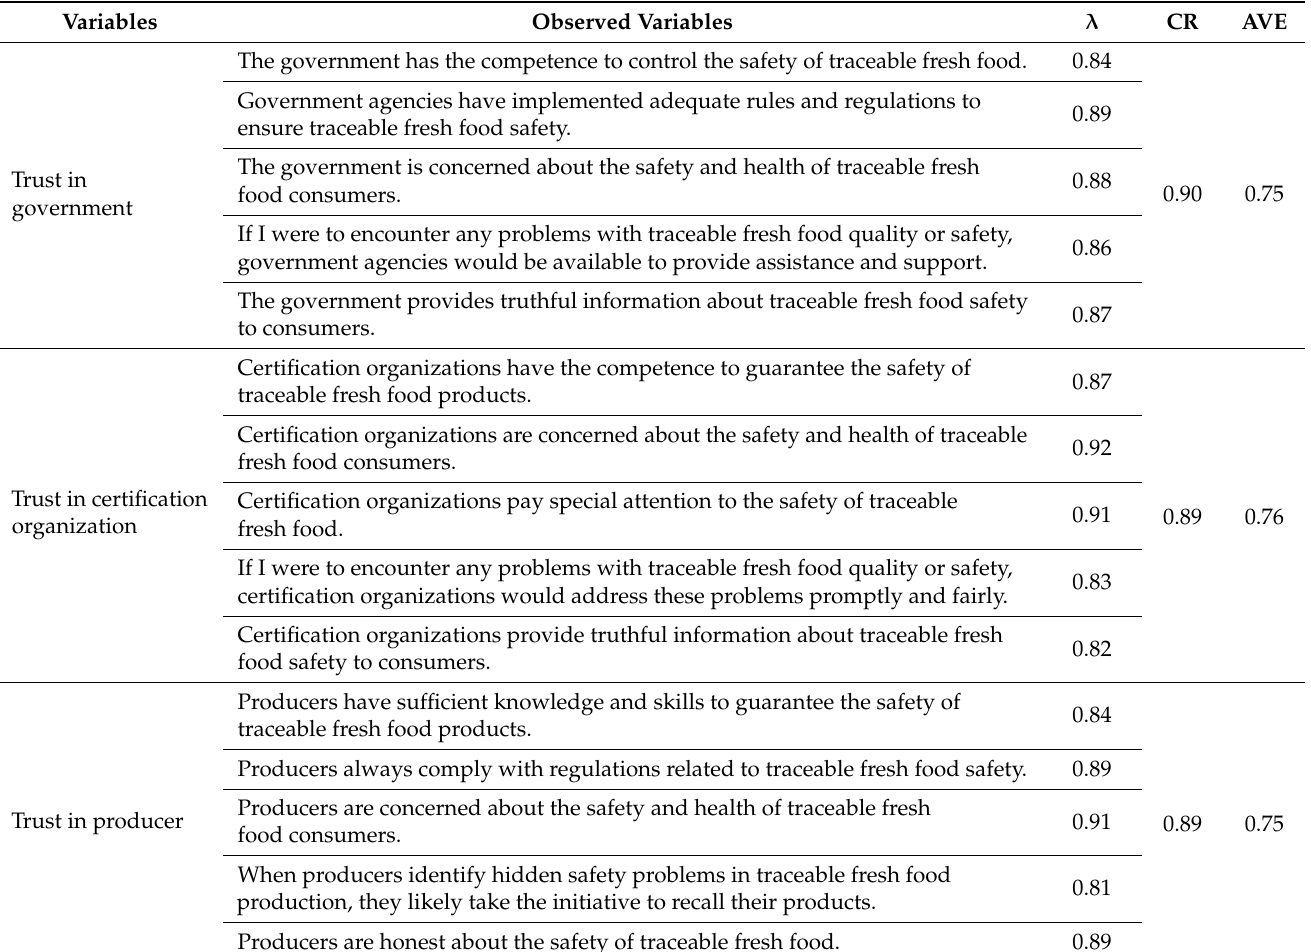
Table 1. Convergent validity tests